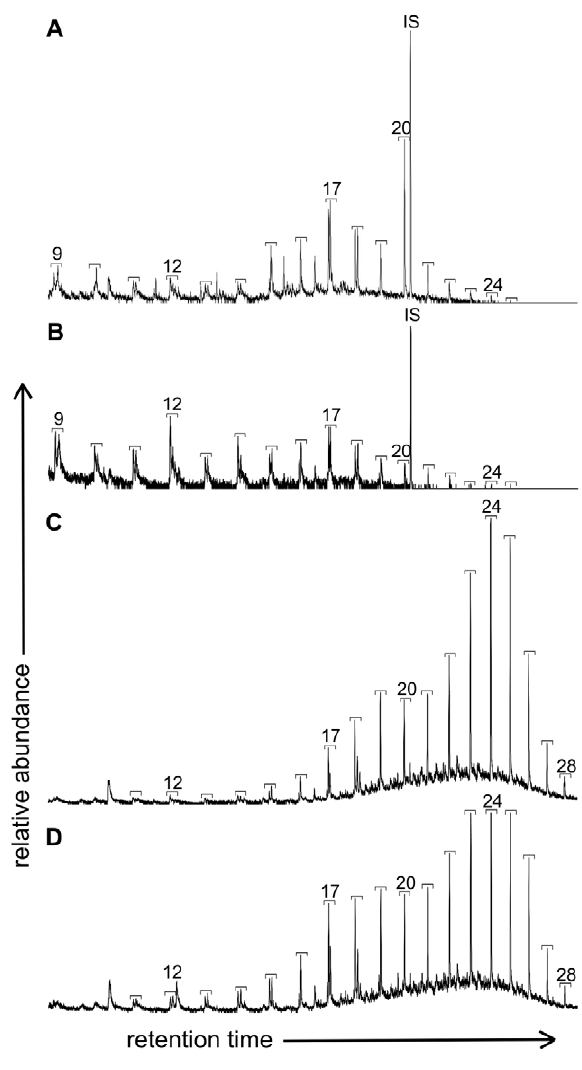
Figure 7. Partial Py-GCMS m/z 57 and 55 chromatograms of Gansusyumenensis feathers. (A) MGSF318 and (B) MGSF317 feathers, and their corresponding matrices (C and D respectively), showing the distribution of n- alkane/ n- alkene moieties. Brackets indicate an n- alkane/ n- alkene doublet and the numbers indicate the carbon chain